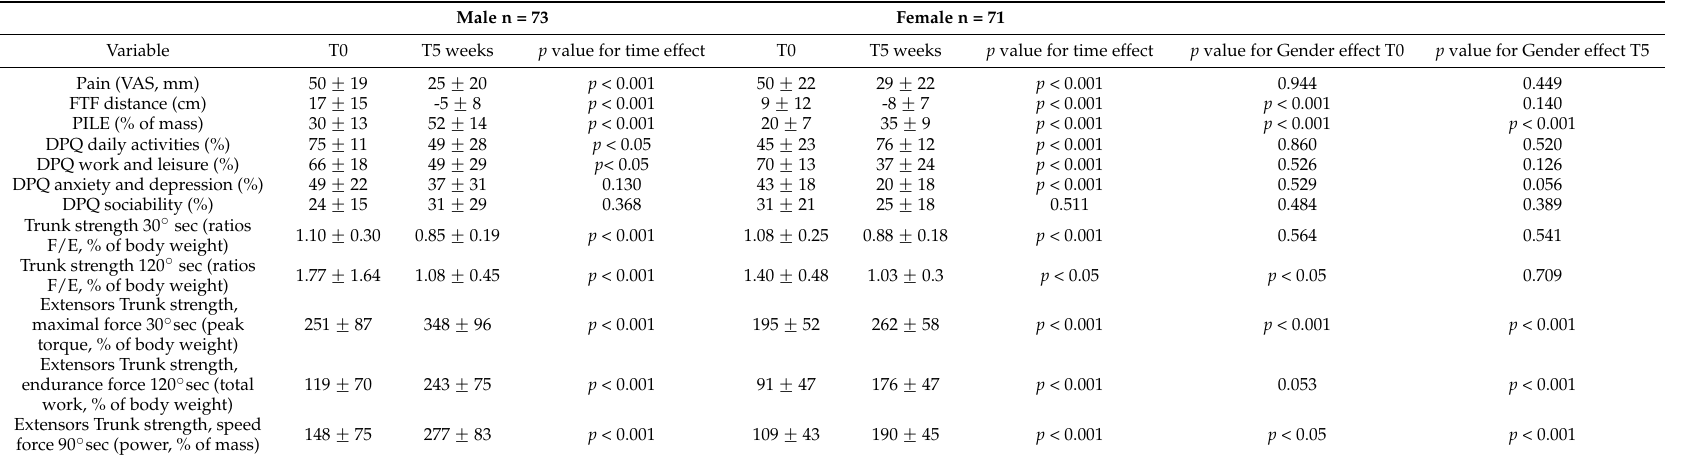
Table 5. Male and female data at T0 and T5